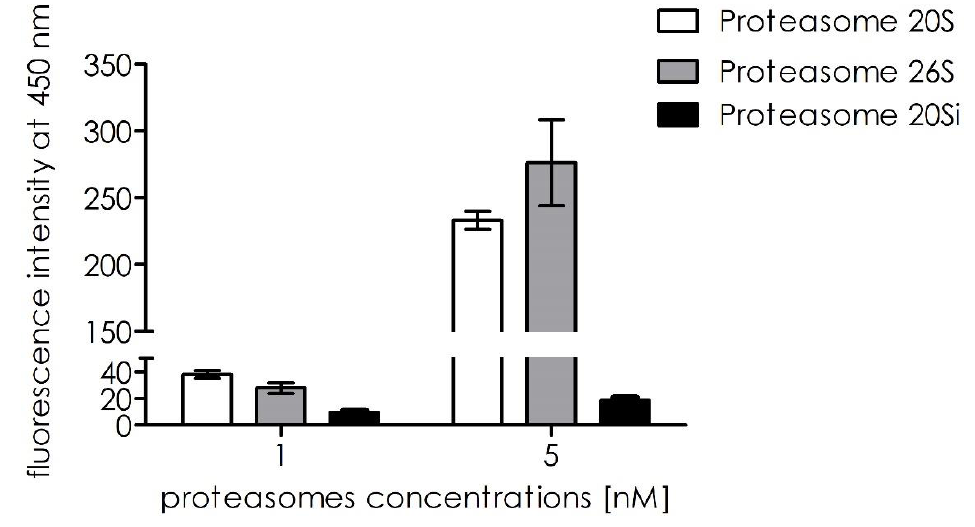
Figure 9. Substrate cleavage rates for the 20S, 26S, and 20S immunoproteasome entities at equimolar concentrations.